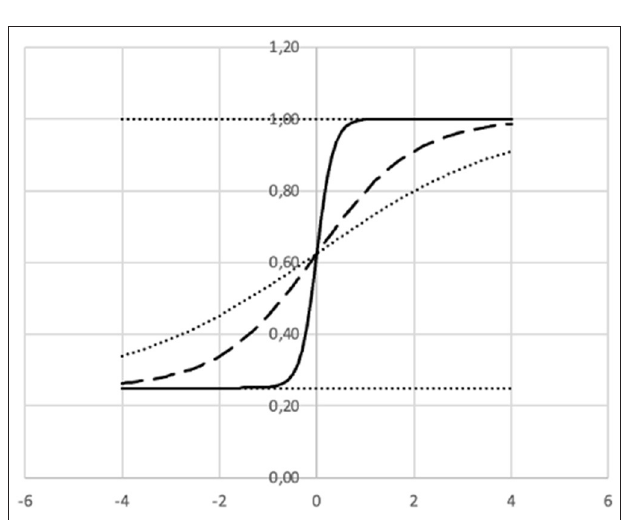
FIGURE 14 | Three examples of item response functions where b = 0 and c =